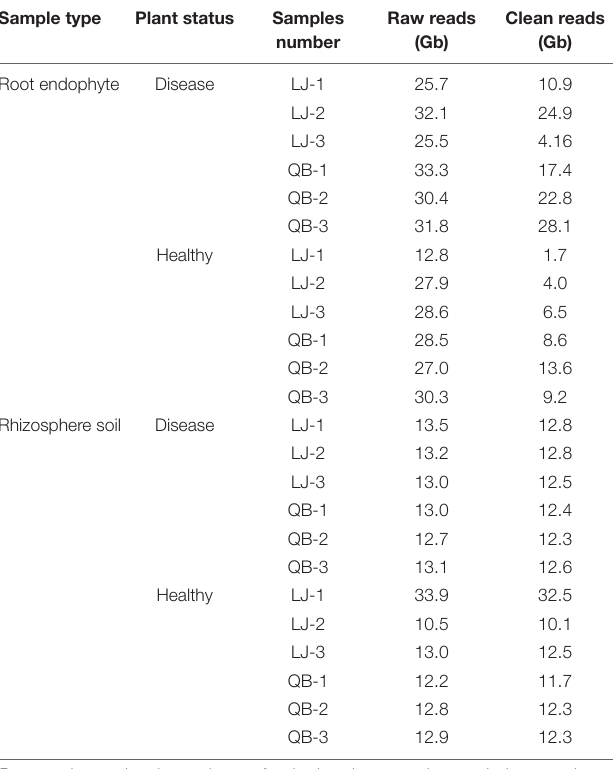
TABLE 1 | Summary table of samples and sequencing